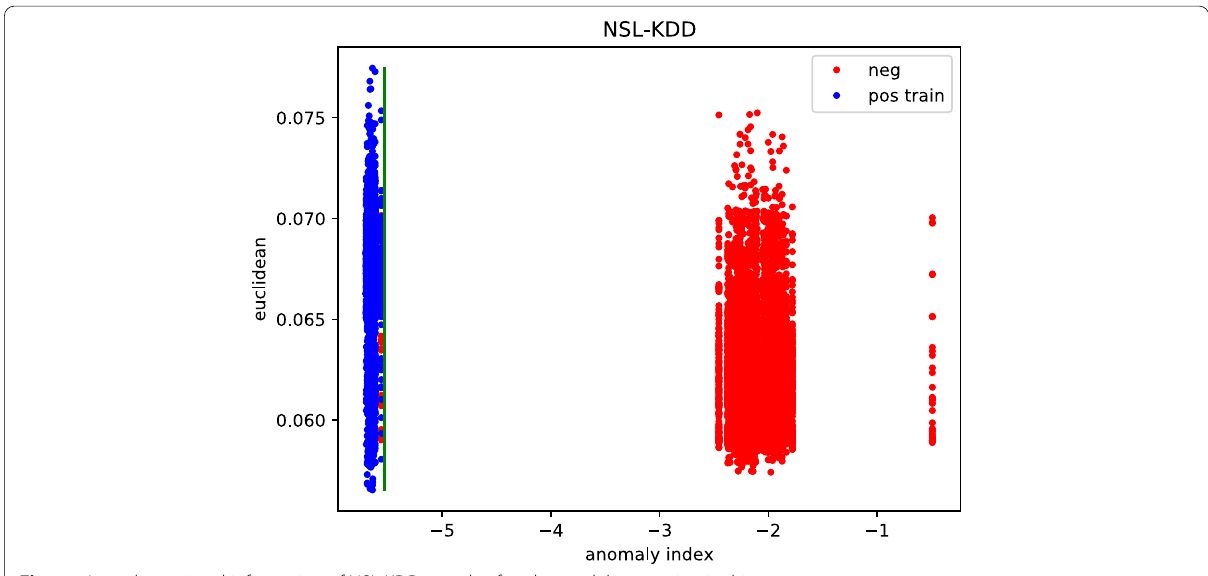
Fig. 11 Low-dimensional information of NSL-KDD sample after the model processing in this paper